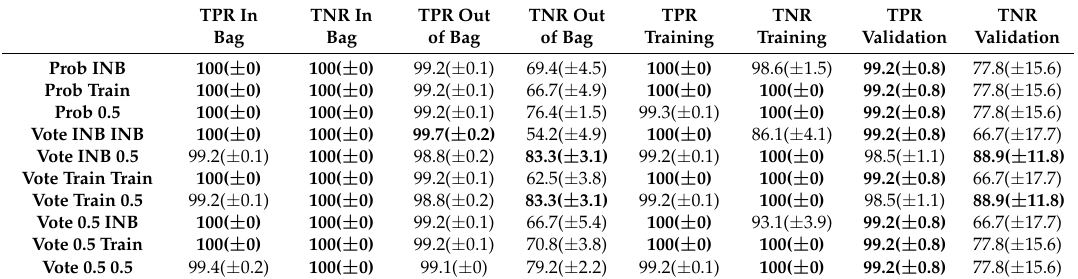
Table A4. True Positive Rate and True Negative Rate for Extreme Tachycardia.